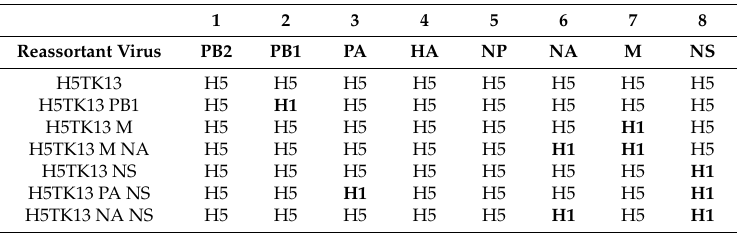
Table 1. Genetic composition of the viruses obtained from the co-infection of the Madin–Darby canine kidney (MDCK) cells with the H1N1 and H5N1 viruses (H1N1 segments in bold).